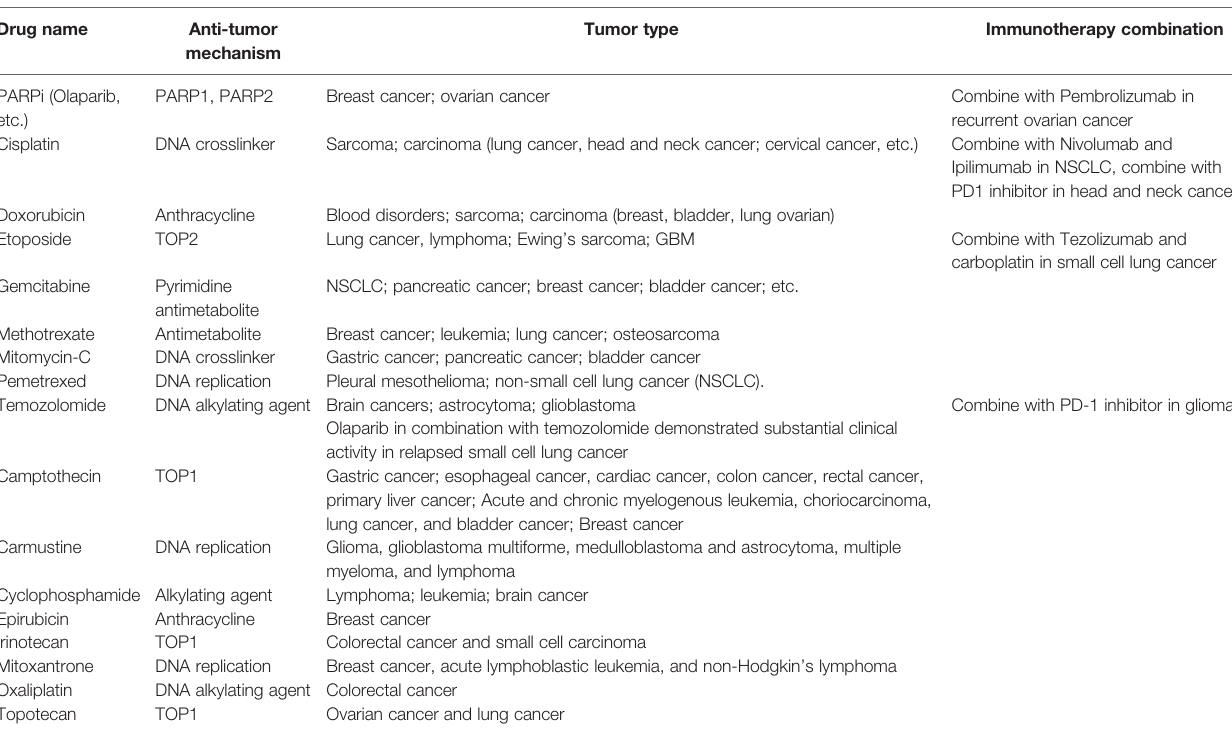
TABLE 1 | DDR-related drugs and combination with immunotherapy in human cancer. Drug